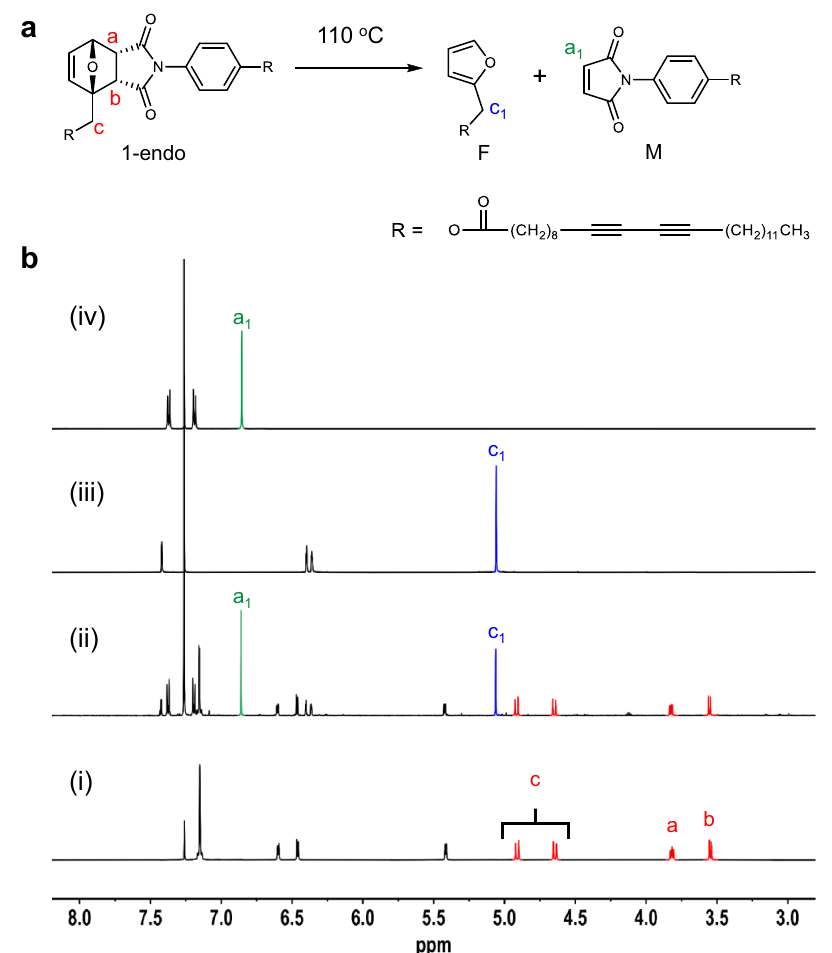
Fig. 4 1 H NMR monitoring of the retro Diels – Alder (rDA) reaction. a Generation of the furan-containing diacetylene F and maleimide-functionalized diacetylene M from the retro Diels – Alder reaction of 1-endo. b 1 H NMR spectra (600 MHz, CDCl 3 ) of 1-endo (i), heat-treated (110 °C, 1 min) 1-endo (ii), independently synthesized furan-containing diacetylene F (iii), and maleimide-functionalized diacetylene M (iv). The 1 H NMR spectrum shown in (ii) was obtained by heating the powder form of 1-endo on a glass substrate for 1 min at 110 °C. The heat-treated sample was dissolved in CDCl 3 and the spetrum was recorded on a 600MHz NMR spectrometer. The red, blue and green colored peaks are from 1-endo, F and M,